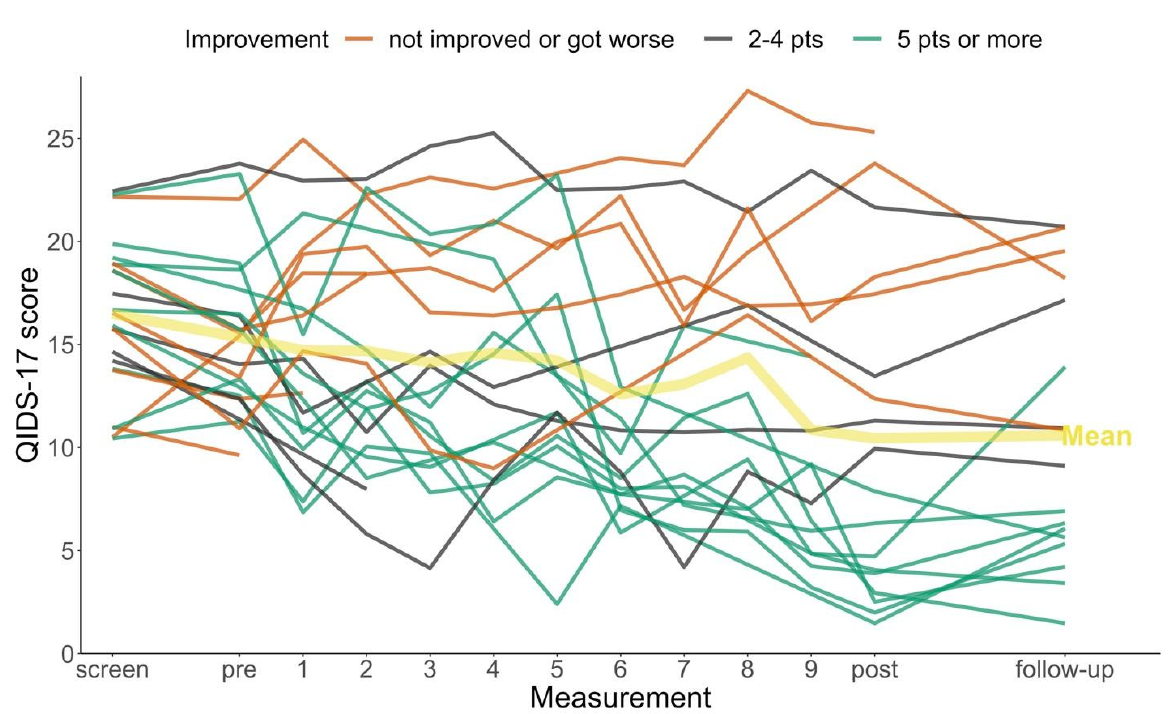
Figure 2. Depression self-ratings (QIDS-A17-SR) over the course of treatment (n = 23). Notes: A slight vertical random jitter was applied to make lines distinguishable in the presence of overlapping sections. Improvement is measured as the difference between QIDS-A17-SR score at “pre” minus the last available measurement. screen: Measurement at screening. pre: baseline measurement. 1–9: measurements after sessions 1–9. post: measurement after session 10 (“end of treatment”).